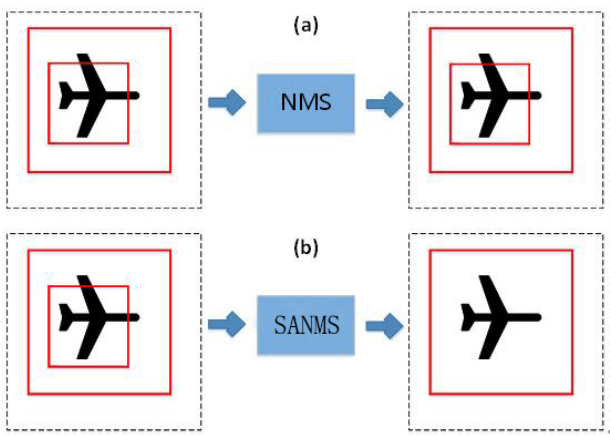
Figure 6. Different methods for filtering multiple detection boxes. ( a ) Non maximum suppression method; ( b ) Small area-based non maximum suppression